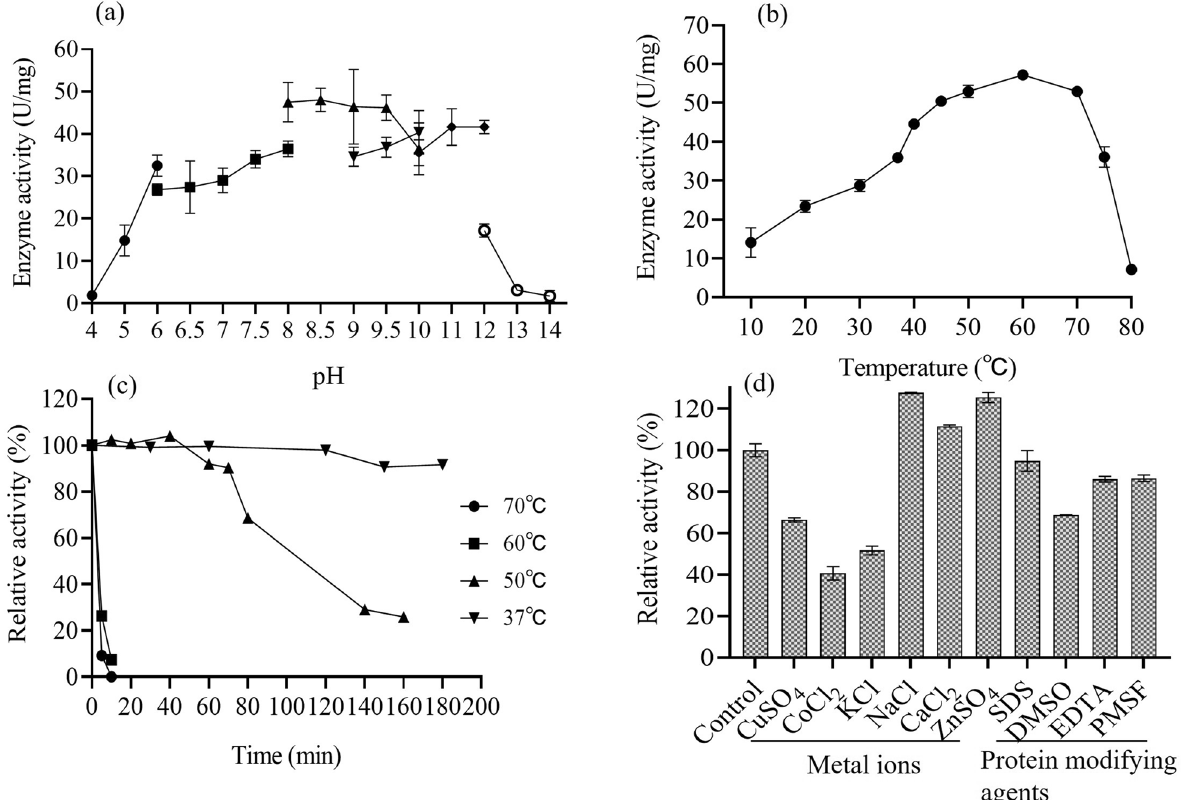
Fig. 4 Effect of different physicochemical parameters on PCH199 L-ASNase activity. Effect of a different buffer pH, b incubation temperature, c thermal stability at different temperatures (37, 50, 60, and 70 ℃ ) and d metal ions and protein modifying agents (1.0 mM) on purified PCH199 L-ASNase